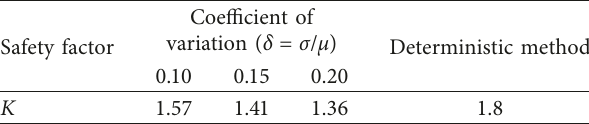
Table 5: Safety factors of bearing capacity of pile